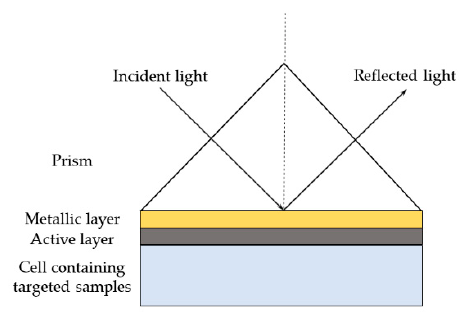
Figure 5. Schematics of the Kretschmann configuration of surface plasmon resonance prism.